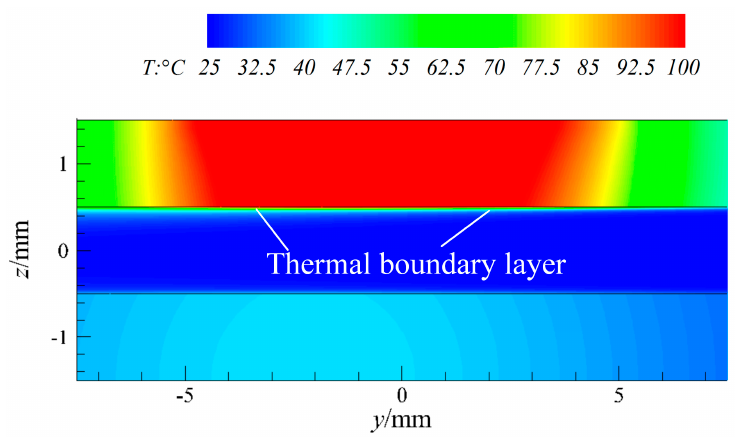
Figure 6. Temperature distribution of channel’s center section ( x = 28.5 mm).